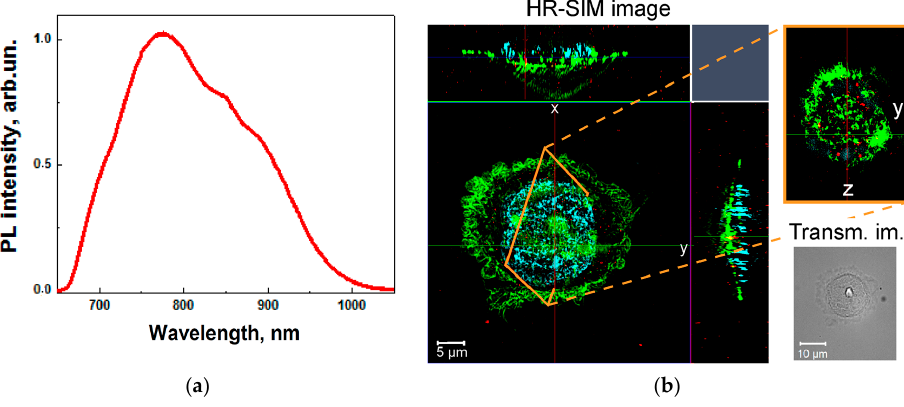
Figure 2. ( a ) Photoluminescence (PL) spectrum of an aqueous suspension of SiNPs; and ( b ) fluorescent HR-SIM image and transmission light image (Transm. im.) of MCF-7 breast cancer cells incubated with SiNPs for 24 h. The cell nuclei were stained with Hoechst 34580 and the cytoplasm actin was stained with Alexa Fluor ® 488 Phalloidin (coloured in cyan and green, respectively). The SiNPs are marked in red.